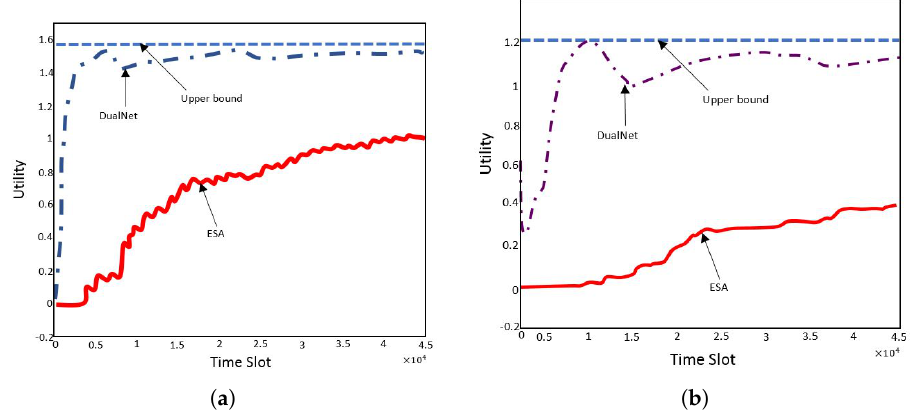
Figure 16. Number of subgradient iterations needed for convergence in the distributed schemes proposed in [5]. ( a ) Utility Performance for Solar Energy Recharging; ( b ) Utility Performance for Wind Energy